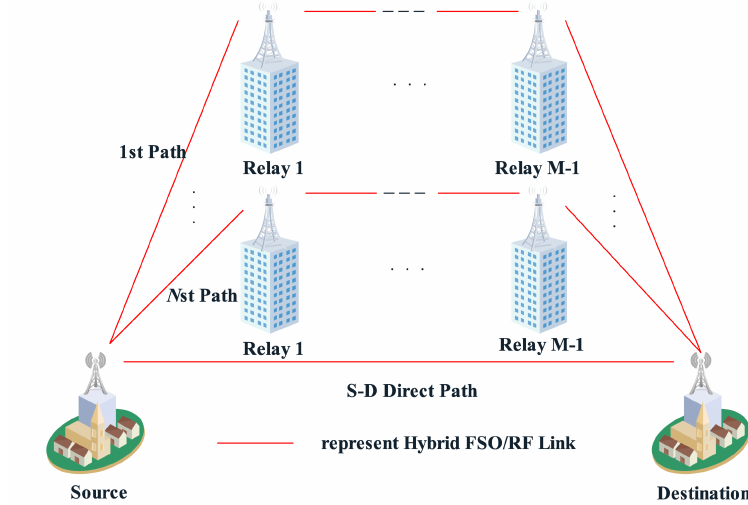
Figure 1. The schematic of the multi-hop parallel hybrid FSO/RF cooperation